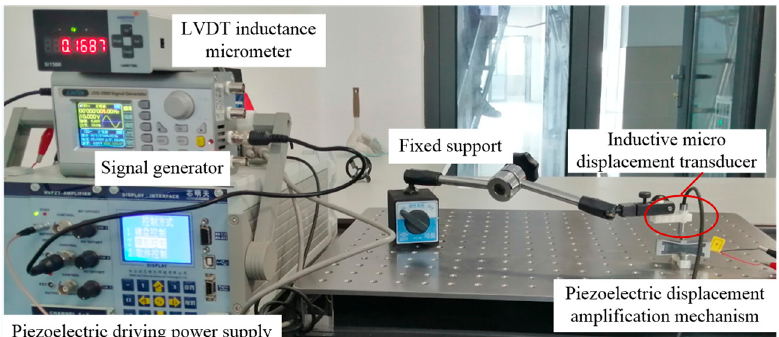
Figure 7. Experimental test system for piezoelectric displacement amplification mechanism.